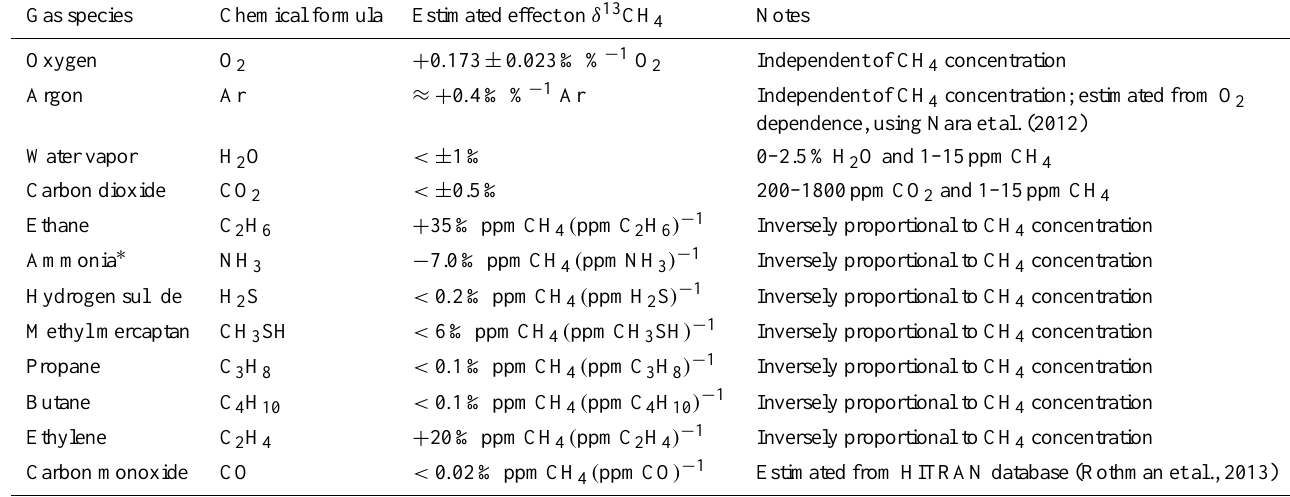
Table 1. Summary of cross-interference due to direct absorption on δ 13 CH 4 from a variety of species. Reported as a slope for linear cross- interference, and as a range (95% coverage factor) for nonlinear cross-interference over a specified range of concentration of the interfering species. A positive sign indicates that the value of δ 13 CH 4 reported by the instrument is more positive than the actual value. See the text for more information.